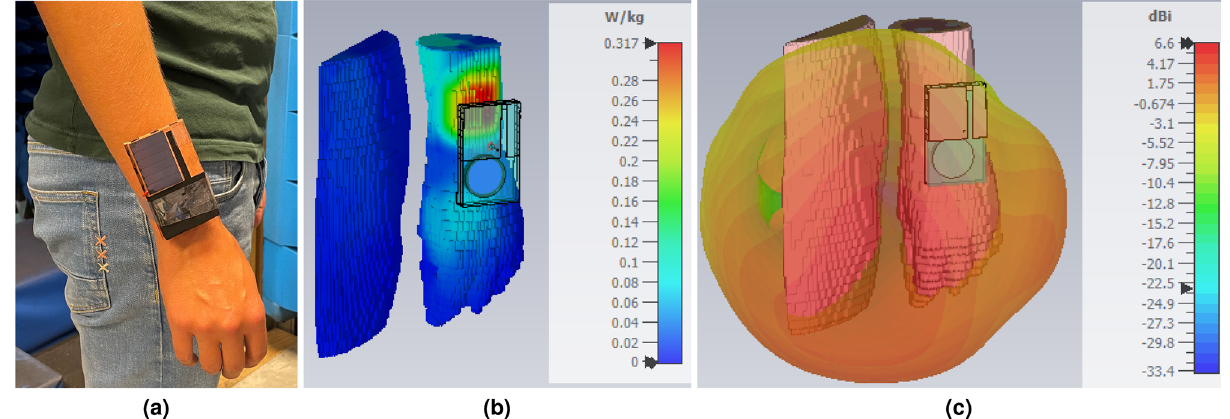
Figure 8. Antenna platform worn around a person’s wrist (a) , simulated SAR according to the IEEE C95.1 standard in front of a real biological model of a wrist at 2.45 GHz (b) and radiation pattern in front of a real biological model of a wrist at 2.45 GHz (c)